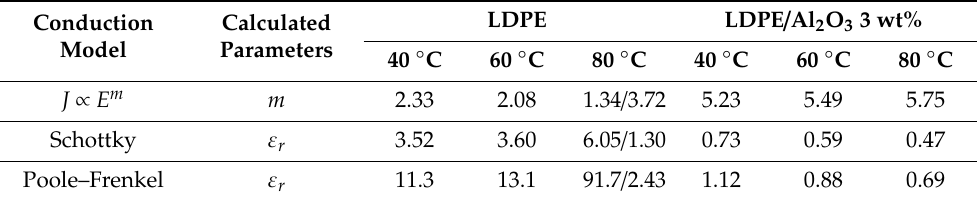
Table 3. Fitting parameters in di ff erent conduction models. Note that the obtained values of the relative permittivity ε r below 1 do not have physical significance.